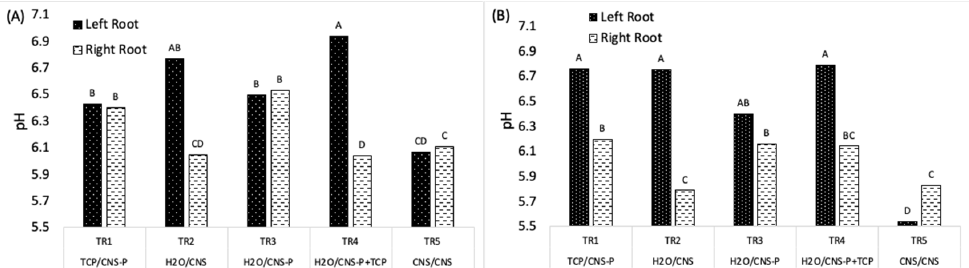
Figure 3. Differences in pH in the culture solutions of various split-root treatments on day 23. ( A ) wild-type barley ( B ) mutant brb barley. The initial pH was adjusted to 7.2. Different letters indicate significant difference ( p < 0.05) among the P treatments.